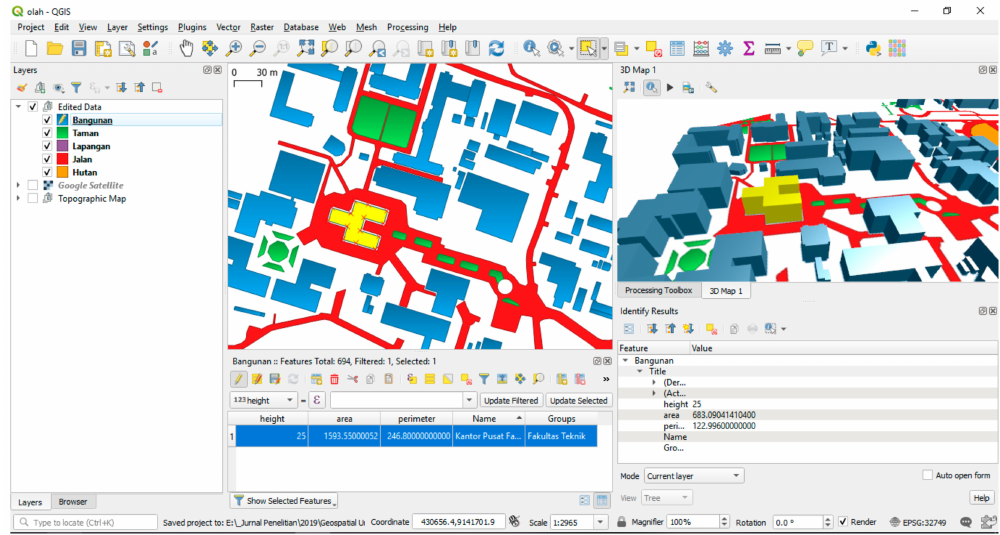
Figure 2. Editing topographic data in